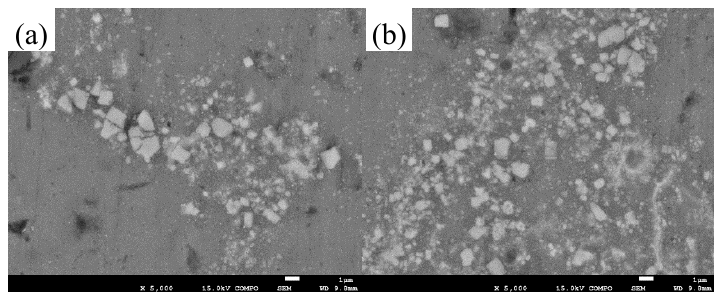
Figure 6. SEM images of TiB 2 particles: ( a ) 3.0 wt. % TiB 2 /7075, ( b ) 4.5 wt. % TiB 2 /7075.